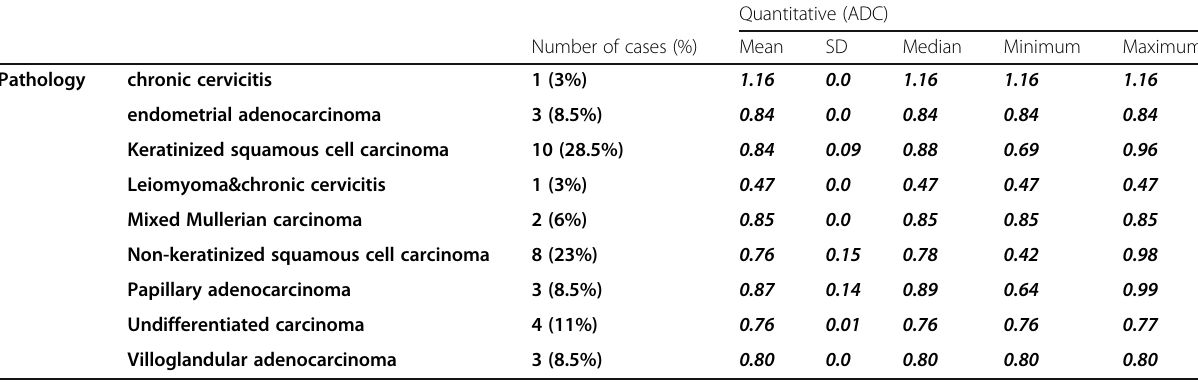
Quantitative (ADC) Number of cases (%)